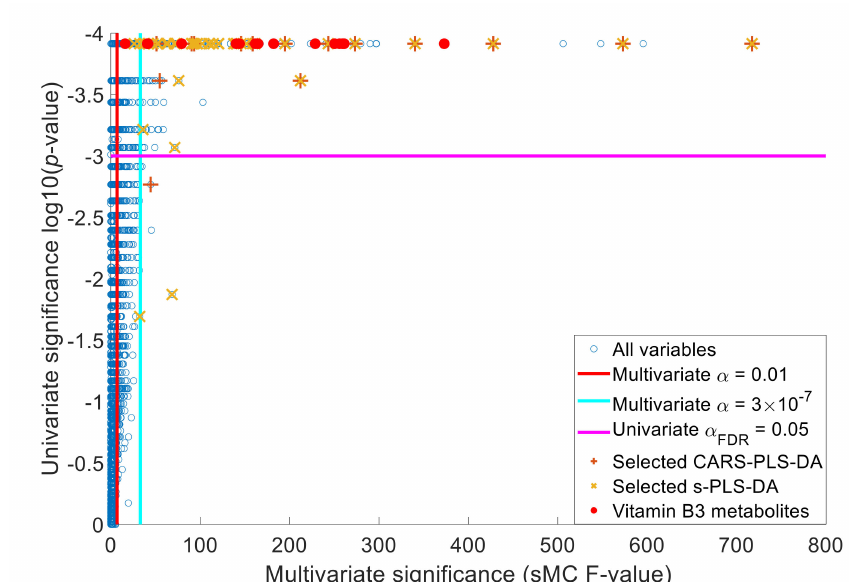
Figure 1. Multivariate significance (sMC F-value) against the univariate significance log10( p -value) of the variables (blue unfilled circles). The vitamin B3 metabolites (red filled circles) were both multivariately and univariately significantly di ff erent between before and during treatment. Despite selecting many significant variables, the sparse variable selection methods sPLS-DA (yellow crosses ( × )) and CARS-PLS-DA (brown plus signs ( + )) did not select the vitamin B3